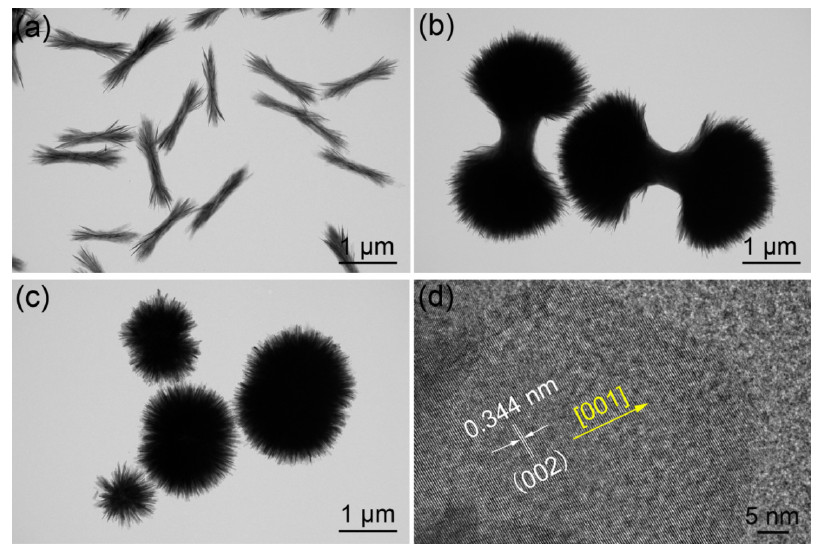
Figure 3. TEM images of the CHA products hydrothermally synthesized by TSC and urea at ( a ) 120 °C with n(TSC)/n(Ca) = 1:1, ( b ) 150 °C with n(TSC)/n(Ca) = 1:1, ( c ) 180 °C with n(TSC)/n(Ca) = 1:2, and ( d ) an HRTEM image of ( c ).